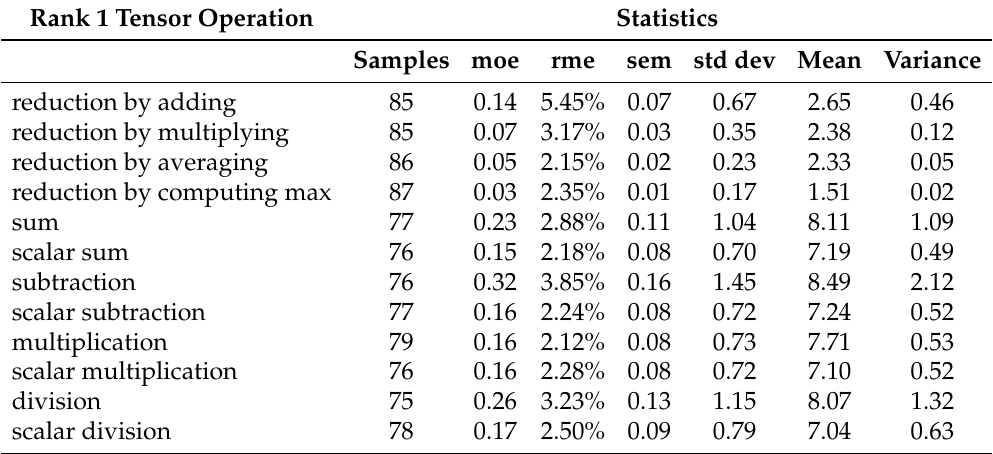
Table 10. Raspberry Pi III B+ benchmark statistics for rank 1 tensor operations with k = 128 (times in ms).